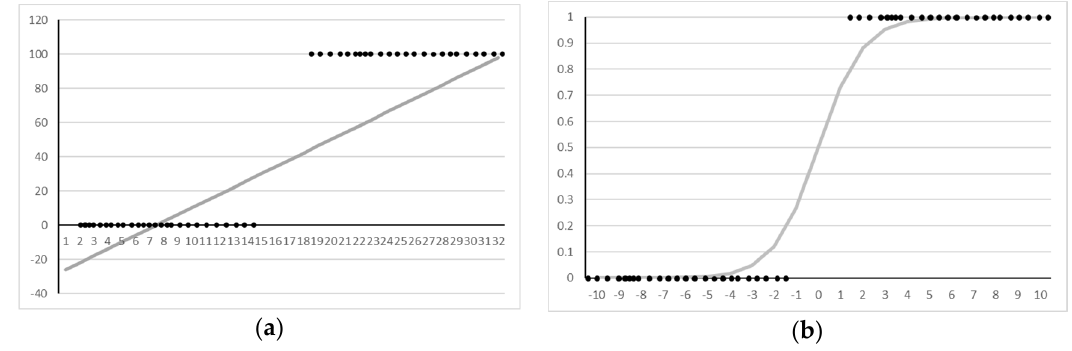
Figure 8. Example of failure feature vector.